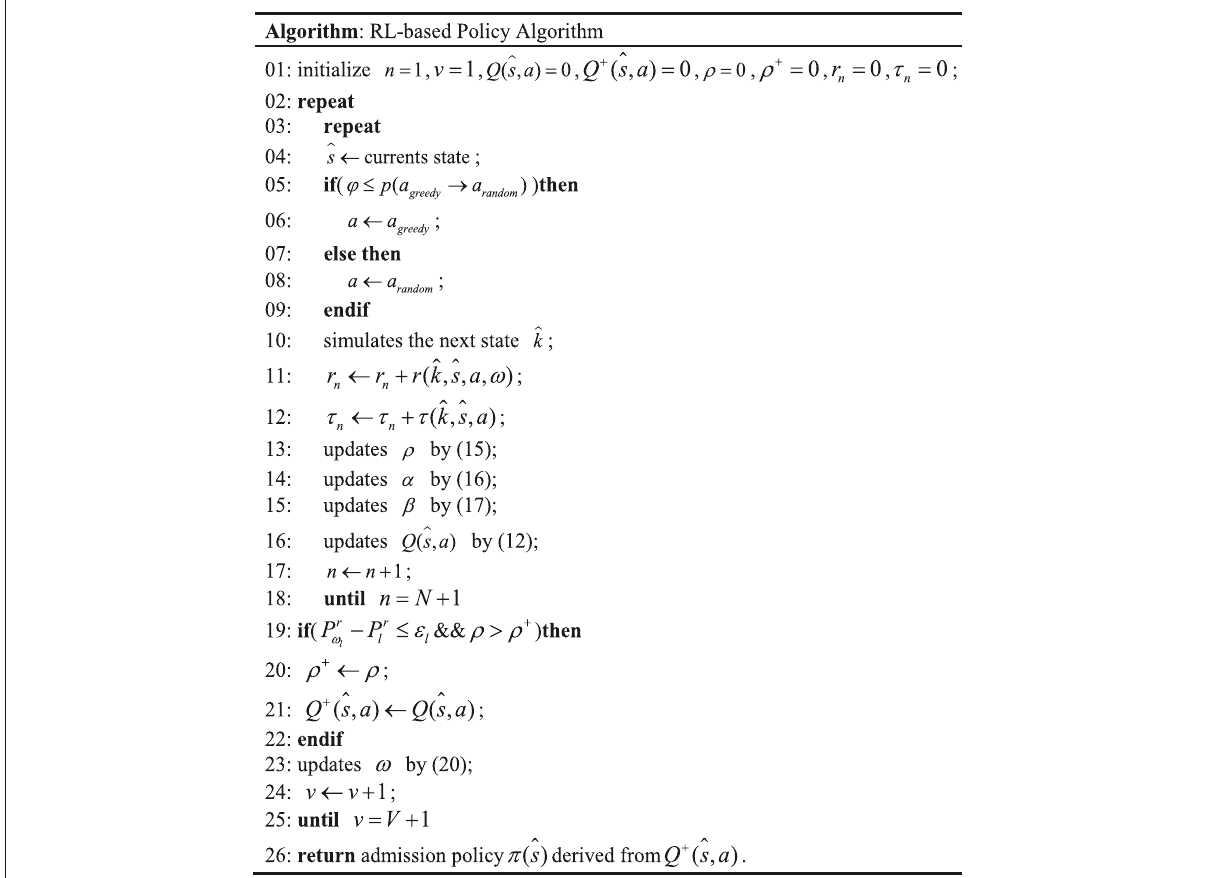
Fig. 4 Pseudo-code of the RL-based policy algorithm. This figure illustrates the pseudo-code of the proposed RL-based task admission control policy algorithm